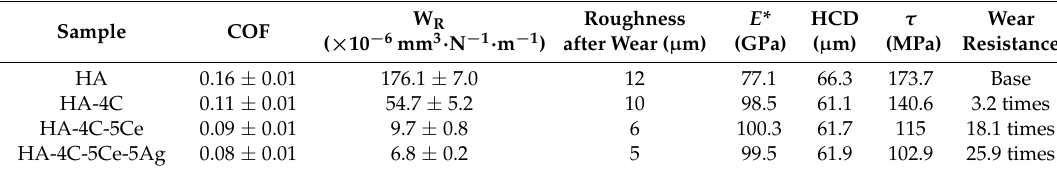
Table 2. Characterization from ball on disc test of HA-based plasma-sprayed